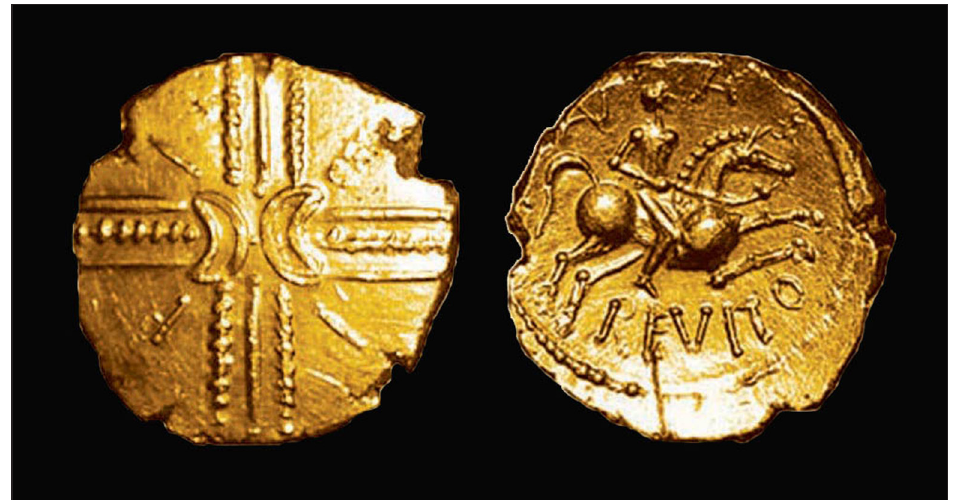
Figure 1: Gold stater of Anarevitos found 2010, PAS ref: FASAM-FCD3A2 © Portable Antiquities